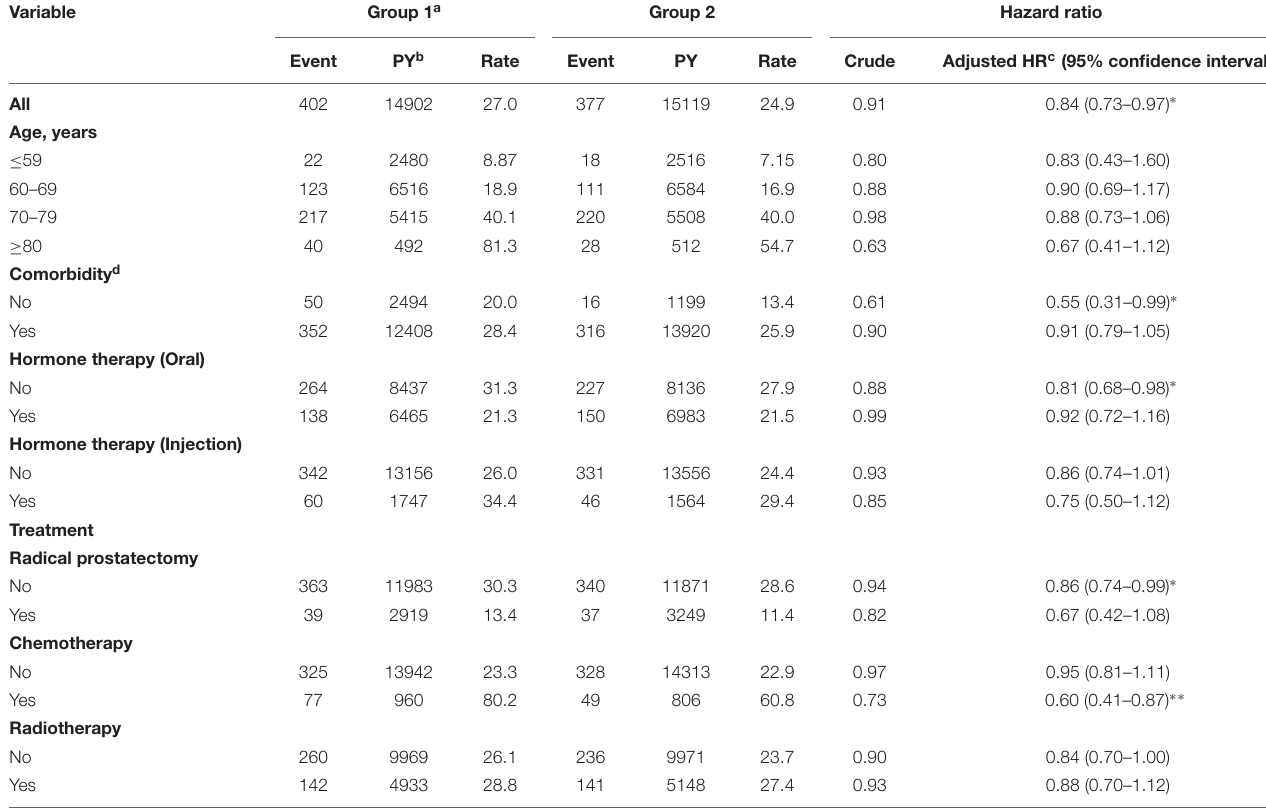
TABLE 2 | Hazard ratios and 95% confidence intervals of PCa mortality in statin user and non-statin user groups. Variable